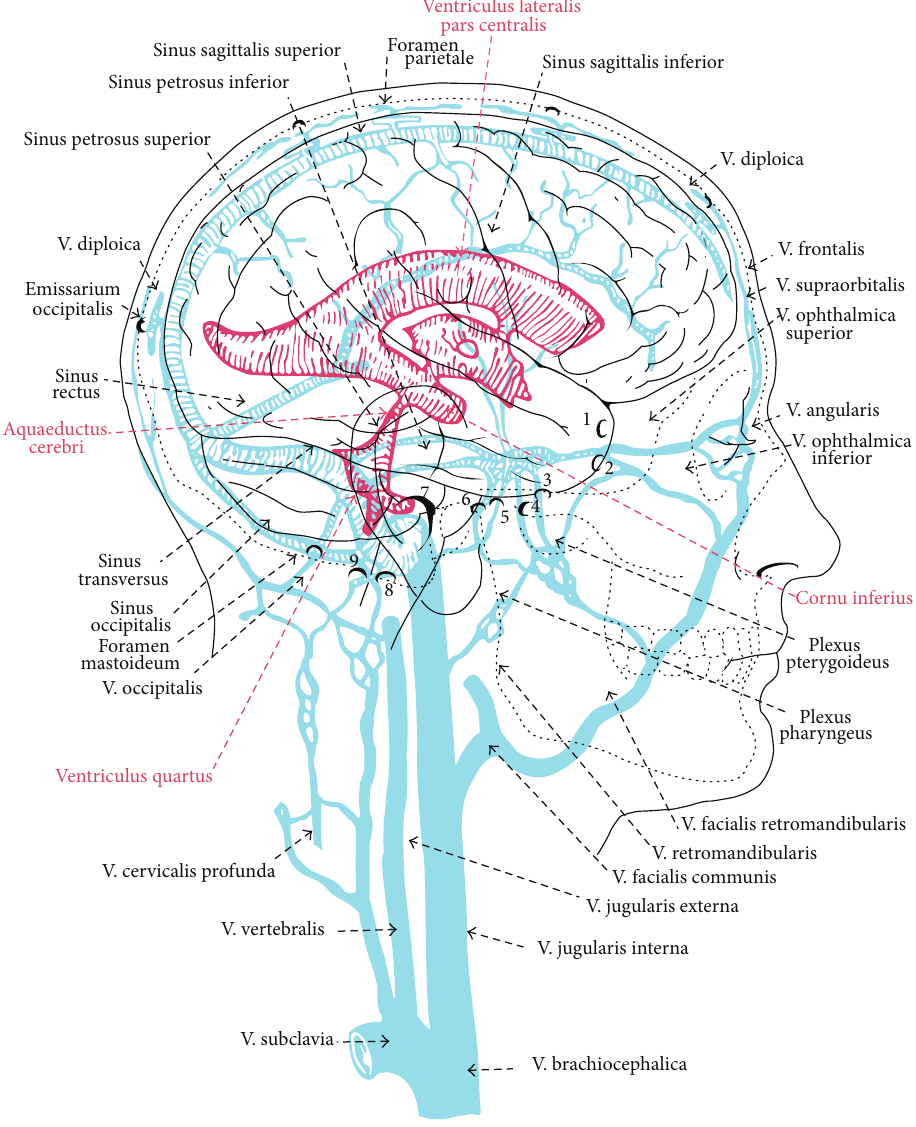
Figure 3: Ventricles, sinuses, and